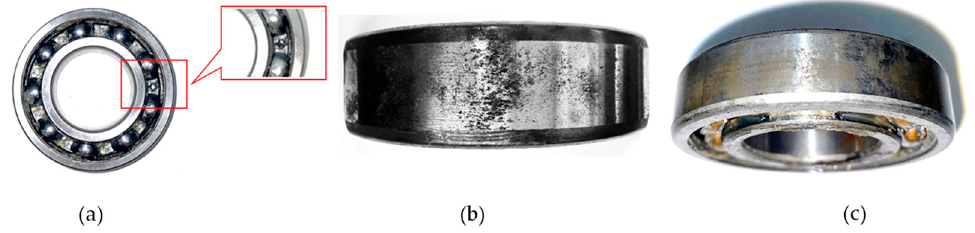
Figure 1. ( a ) Ball bearing structure. ( b ) Outer raceway fault. ( c ) Inner raceway fault.